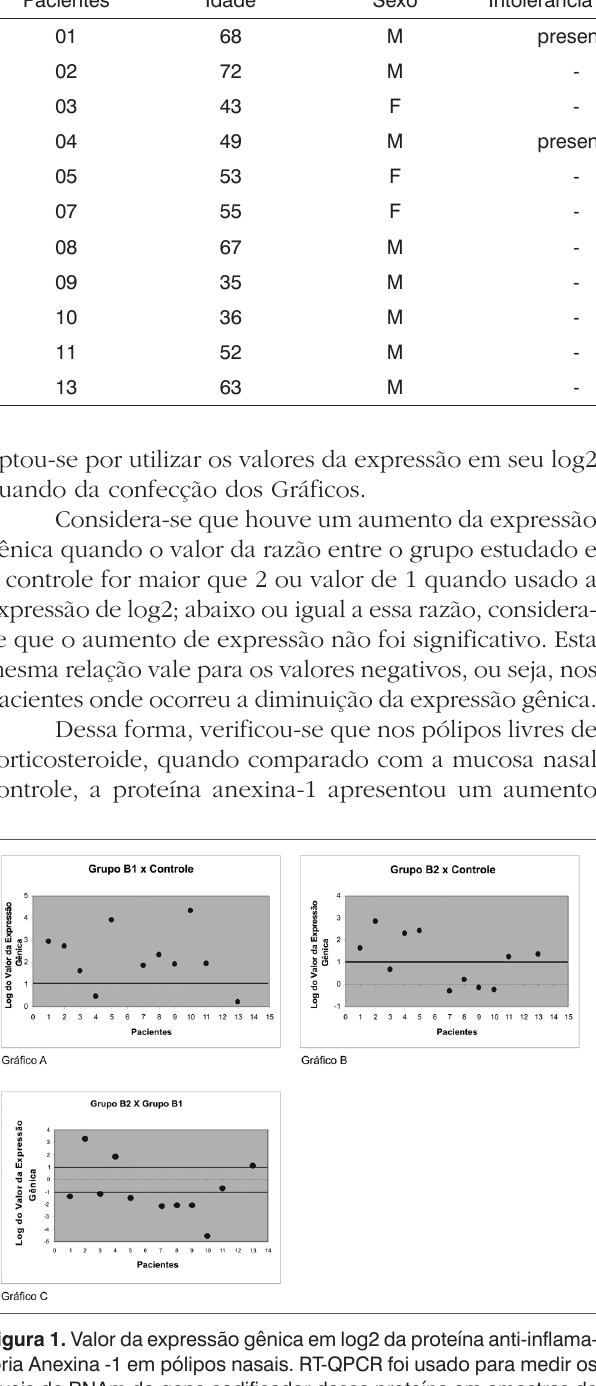
Figura 1. Valor da expressão gênica em log2 da proteína anti-inflama- tória Anexina -1 em pólipos nasais. RT-QPCR foi usado para medir os níveis de RNAm do gene codificador dessa proteína em amostras de mucosa nasal normal - grupo controle, pólipo sem uso de corticoide - grupo B1 e pólipo em uso de corticoide - grupo B2. A expressão gênica da proteína Anexina - 1 em tecidos de pólipo sem corticoide em relação a tecidos de controle (Gráfico A), pólipos com uso de corticoide em relação ao controle (Gráfico B) e pólipos com uso de corticoide em relação a pólipos sem uso de corticoide (Gráfico C).